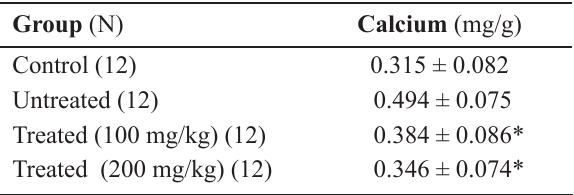
Table 3 – Contents of calcium in dry murine left kidney tissue